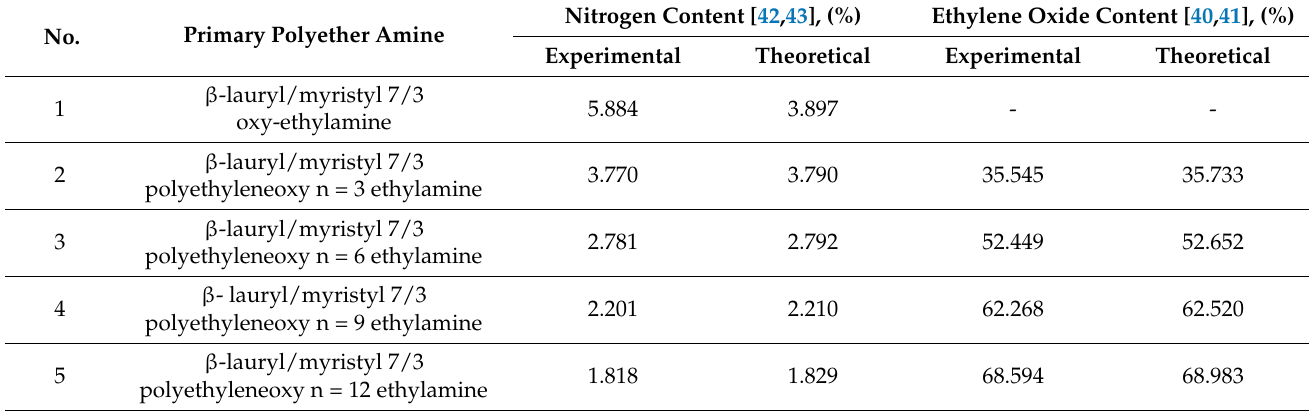
Table 7. The main chemical characteristics of homogeneous primary β -lauryl/myristyl 7/3 polyethyleneoxy n = 3–18 ethylamines, LM(EO) n